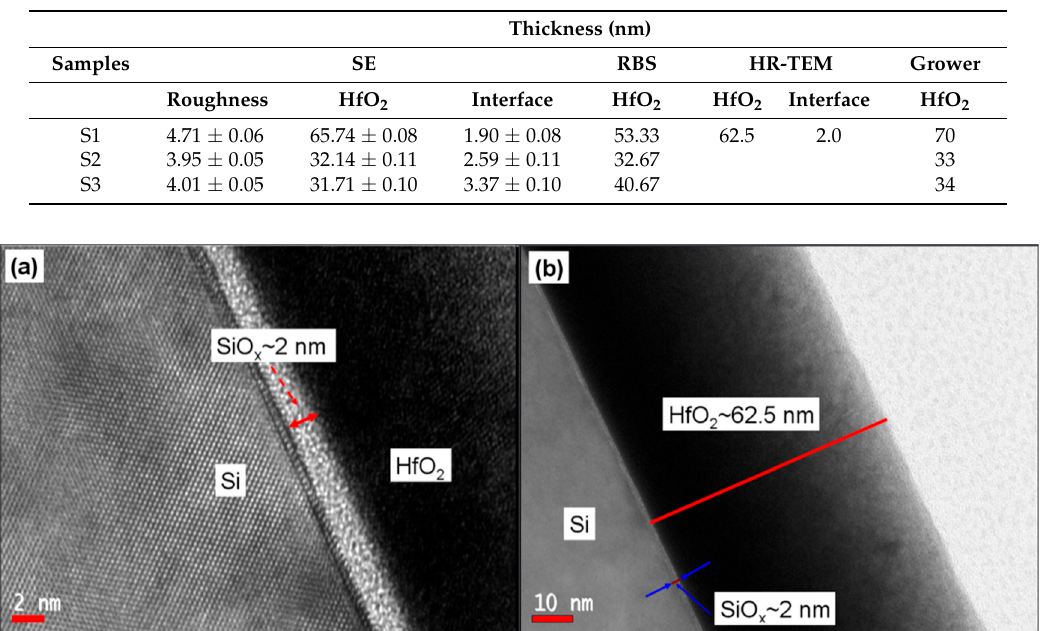
Figure 9. HR-TEM images of the S3 with scale of ( a ) 2 nm, and ( b ) 10 nm, respectively.